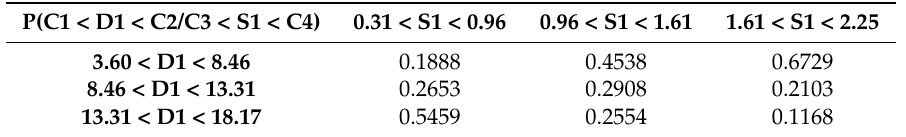
Table 5. Conditional probability of buried depth falling into different ranges given the condition of the surface water irrigation volume in different ranges.